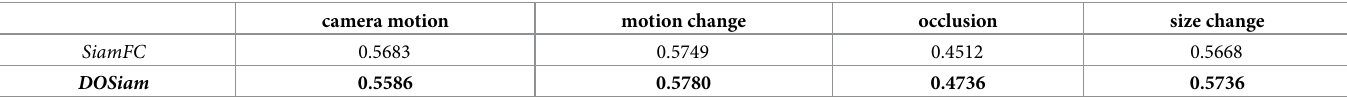
Table 5. Comparison with SiamFC in terms of accuracy in some attributes on VOT2019-RGBT(TIR).